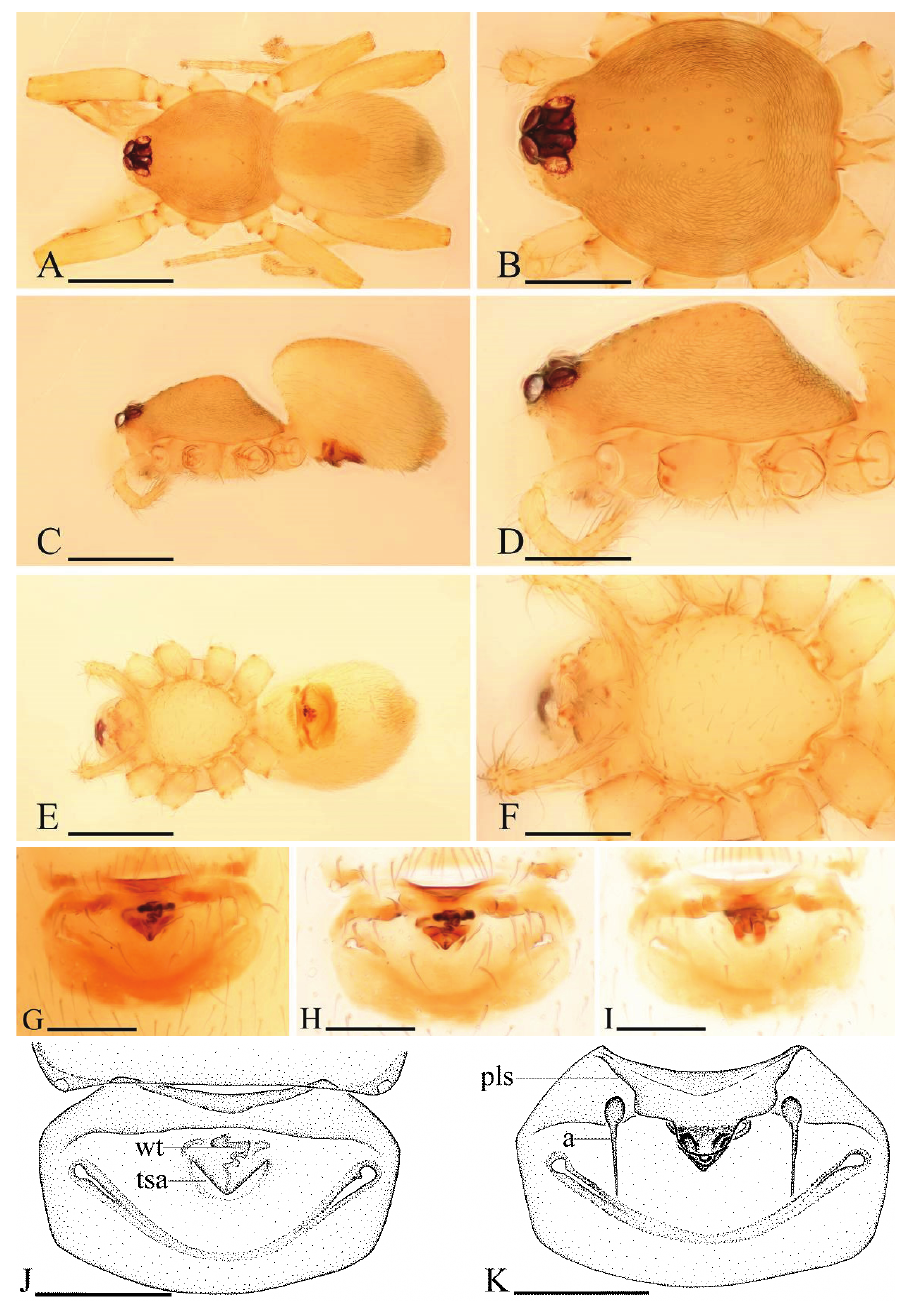
Figure 14. Ischnothyreus tectorius sp. n., female. A, C, E habitus, dorsal, lateral and ventral views B, D, F pro- soma, dorsal, lateral and ventral views G, H, J epigastric region, ventral view I, K epigastric region, dorsal view ( H, I cleared in lactic acid). Abbreviations: a = apodeme; pls = plate-like sclerite; tsa = triangular-shaped atrium; wt = winding tube. Scale bars: A, C, E =0.4 mm; B, D, F = 0.2 mm; G–K = 0.1